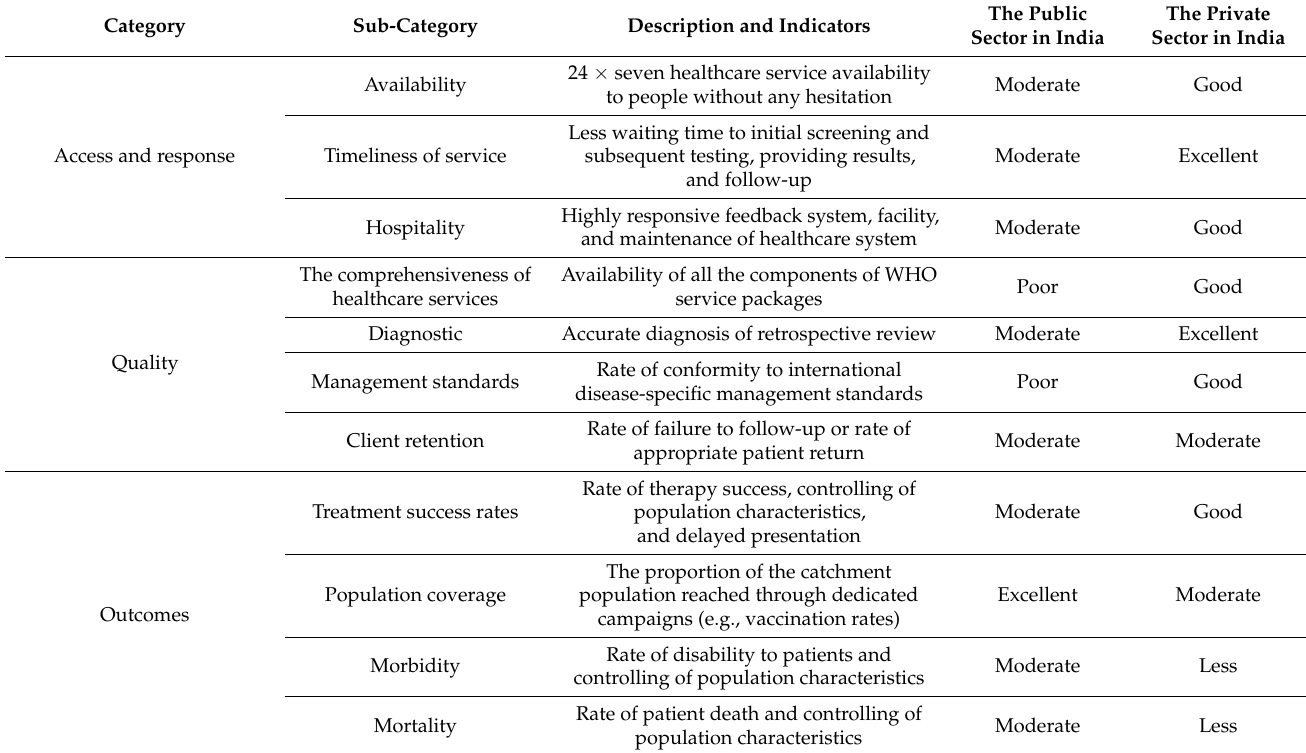
Figure 4. Indian healthcare system. Table 1. WHO indicators for suitable healthcare systems and Indian